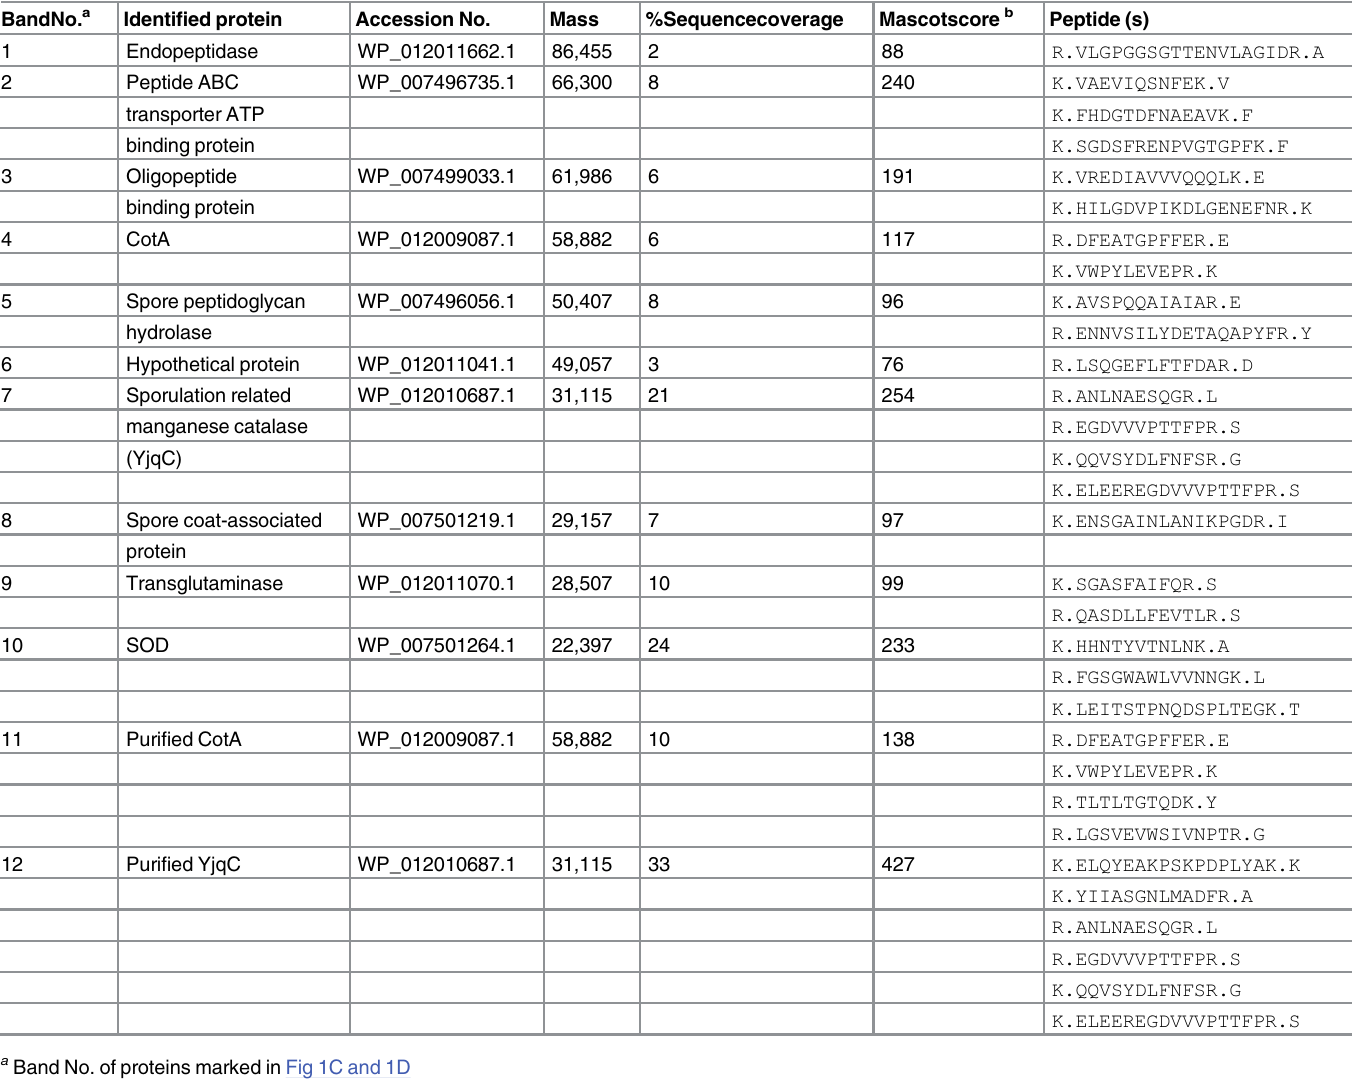
Table 1. Identification of proteins extracted from spore coat fraction of B . altitudinis SYBC hb4. BandNo. a